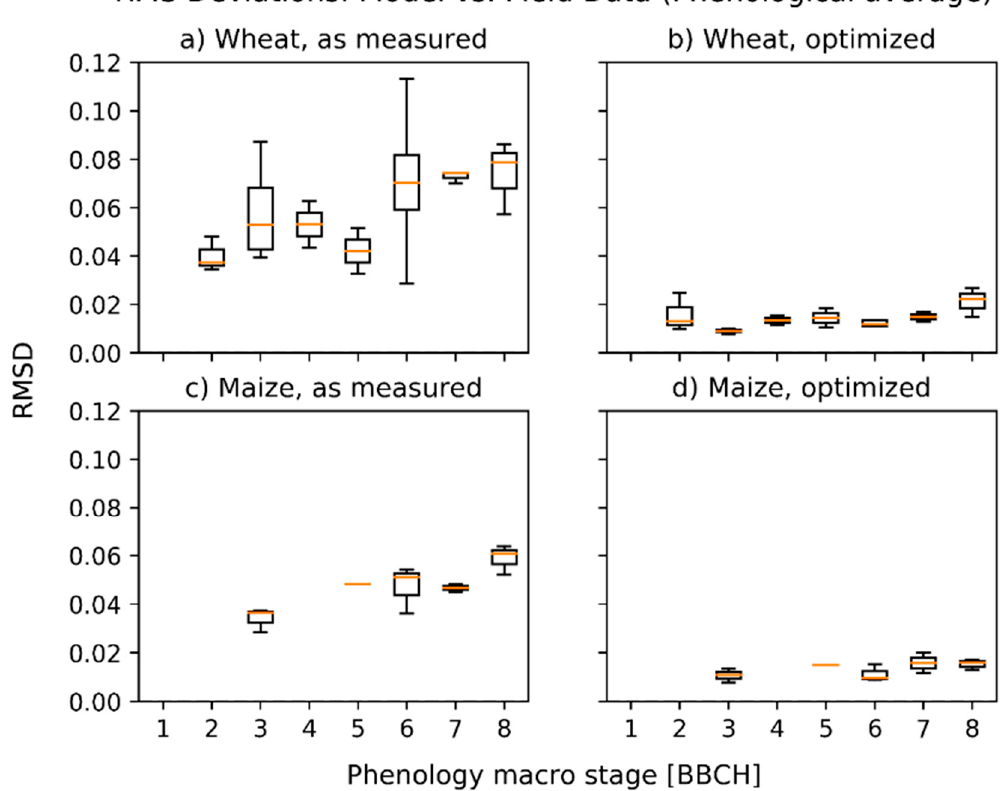
Figure 8. Results of the spectral fitting aggregated into BBCH growth stages. RMSD values were first calculated for the full range of the spectrum without adaptation (wheat: a , maize: c ). A higher accuracy was obtained after fitting the spectral curves in the NIR range by changing ALIA, EWT and C brown (wheat: b , maize: d ).